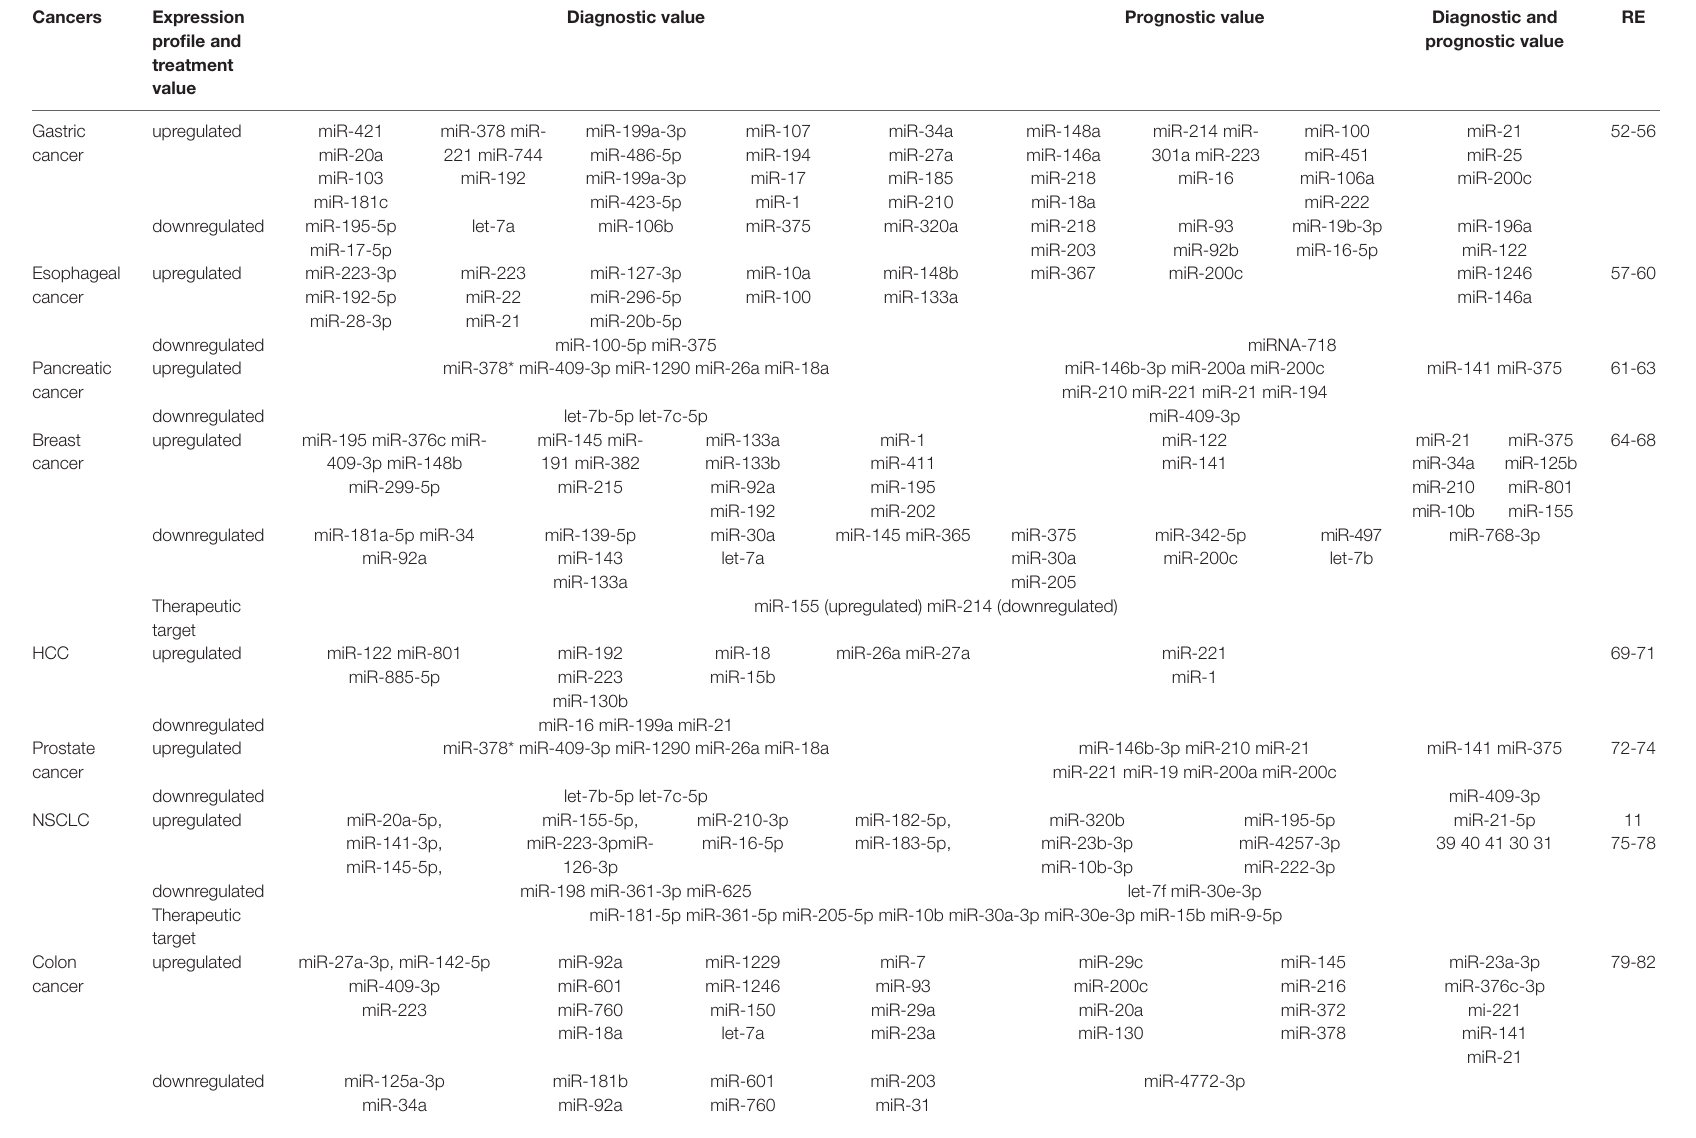
TABLE 1 | Values of circulating miRNAs in different cancers. Cancers Expression